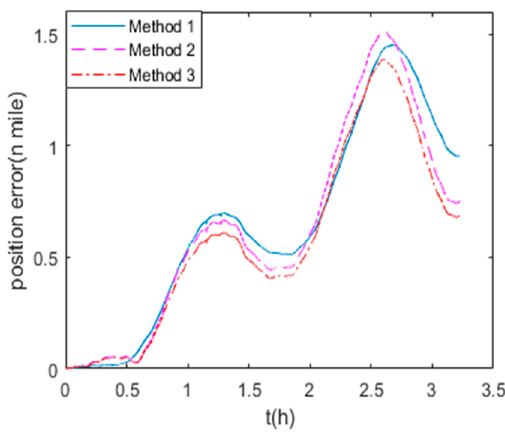
Figure 14. Position errors of three navigation results.